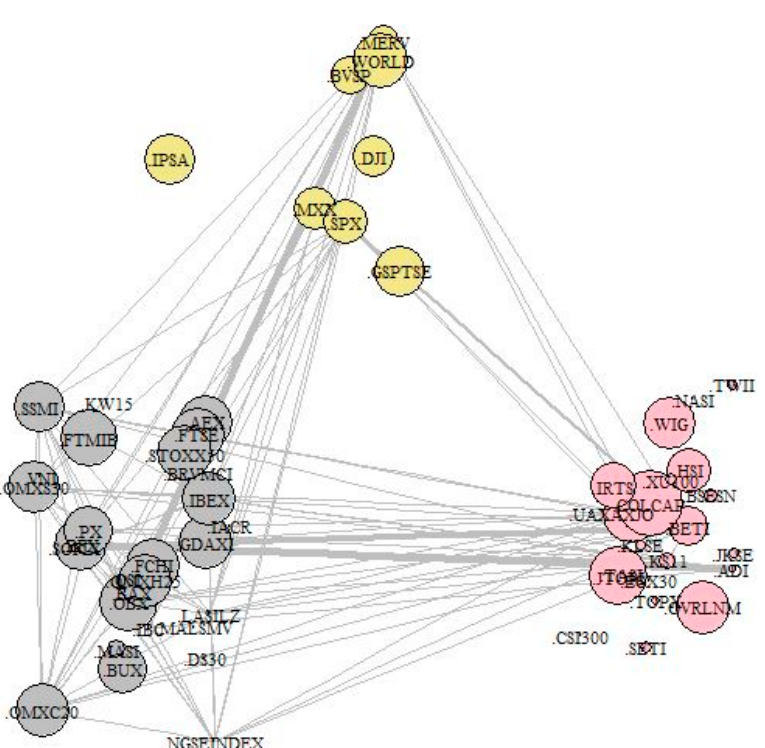
Figure 9. Two Gaussian-kernel based normalized modularity clusters (part of the total graph).